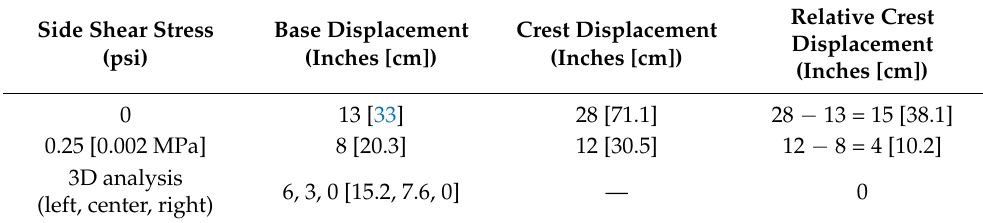
Table 10. 2D Study Case 5, estimated permanent displacements for the MYG008-50k Earthquake using long-term strengths.